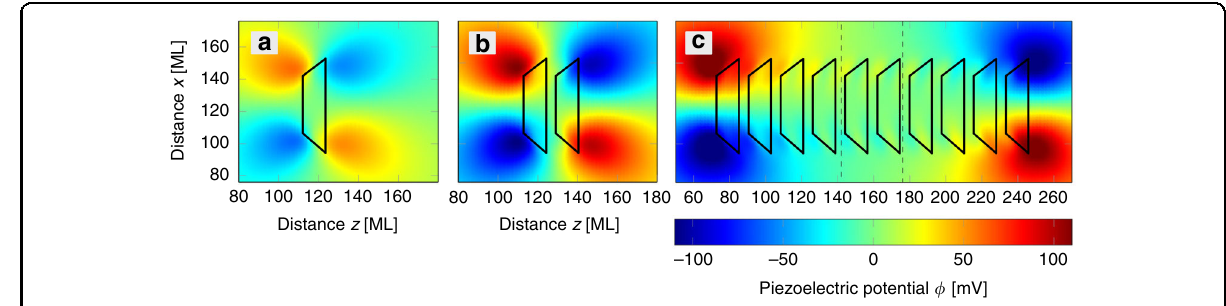
Fig. 2 Piezoelectric potential distribution in the (010)-plane cut 20 ML outside of a one, b two, and c stack of ten InAs